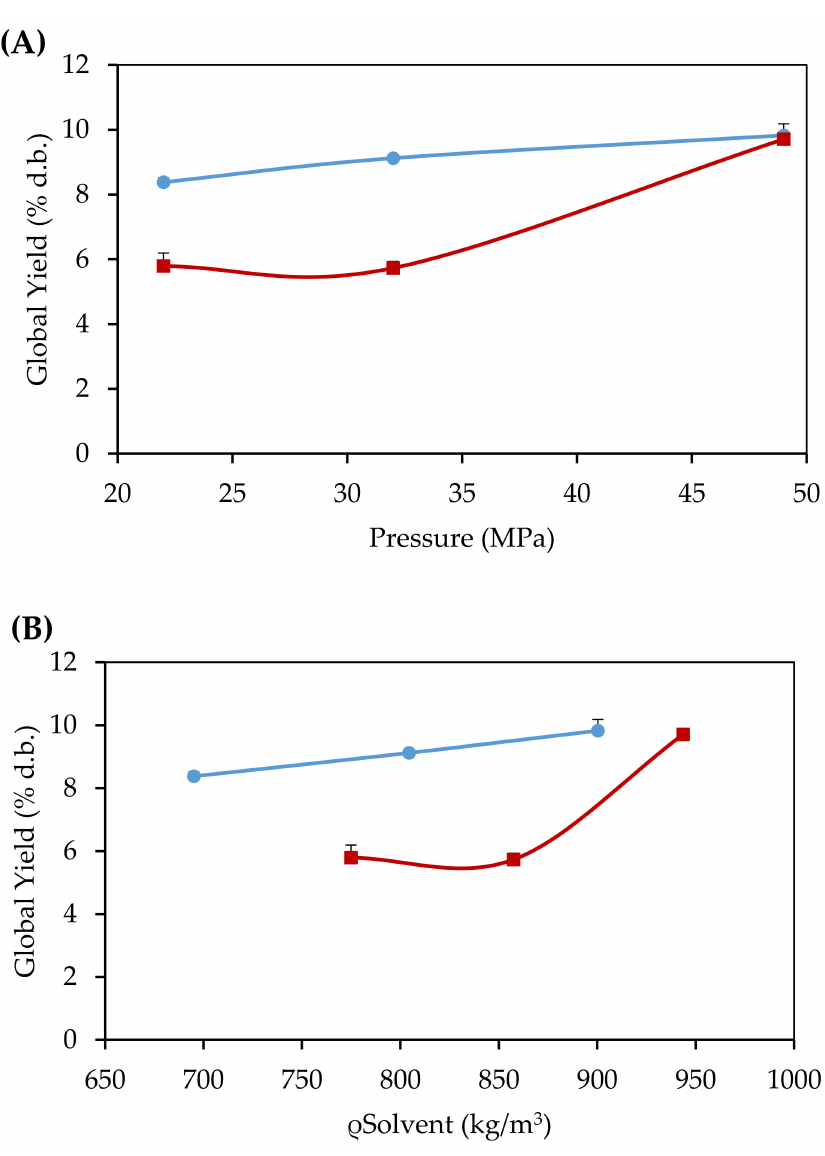
Figure 1. Global yield isotherms of murici pulp extracts ( B. crassifolia ) obtained by CO 2 -SFE ( ) ( A ) and CO 2 +EtOH-SFE ( ) ( B ), at 343.15 K (Standard deviations ≤